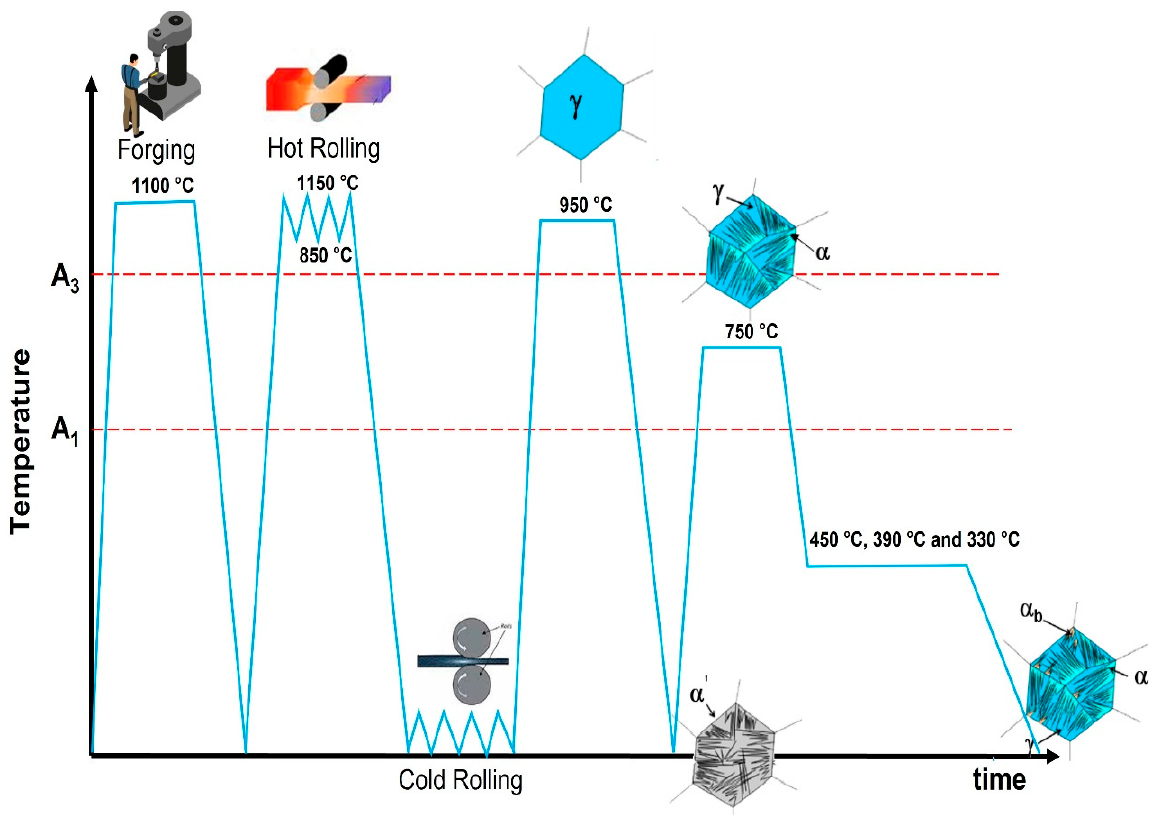
Figure 1. Thermomechanical treatment used in order to induce the TRIP microstructure.